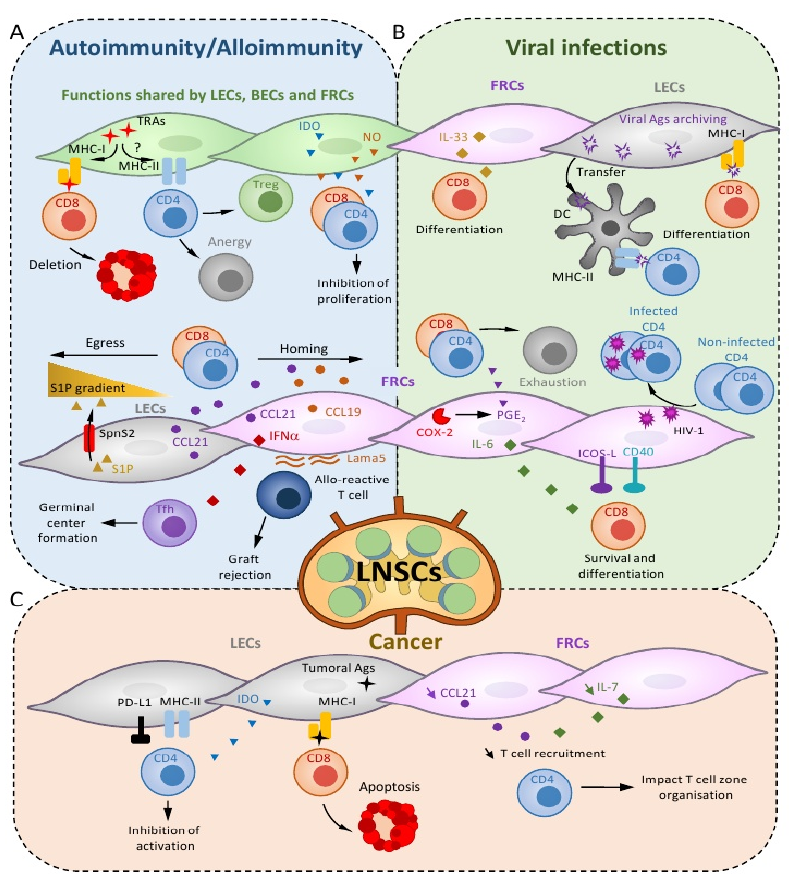
Figure 2. Impact of lymph node stromal cells on T cell immunity. Depending on the inflammatory context, stromal cells in LNs can differentially impact T lymphocytes. ( A ) Inautoimmunity /